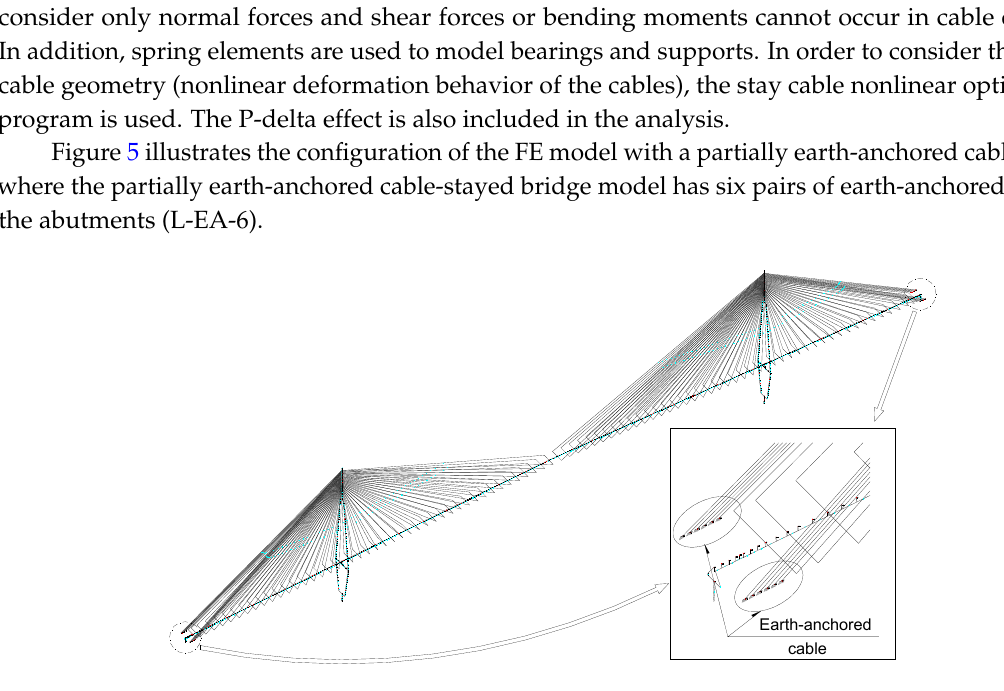
Figure 5. 3-D FE model of the considered bridge. FE, finite Figure 5. 3 ‐ D FE model of the considered bridge. FE, finite element.